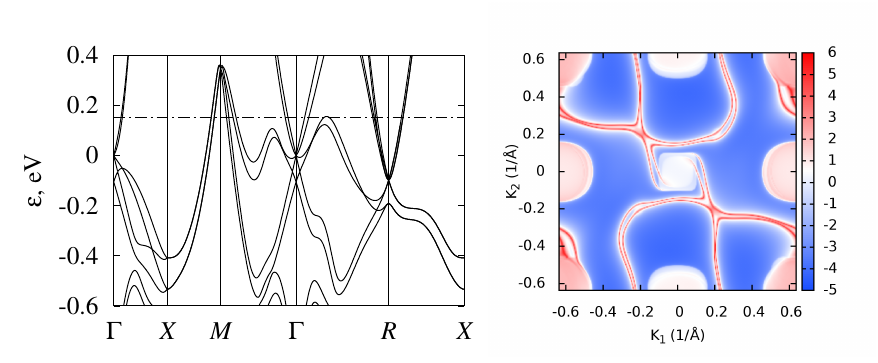
Figure 9. Band structure and surface Fermi arcs in RhGe.